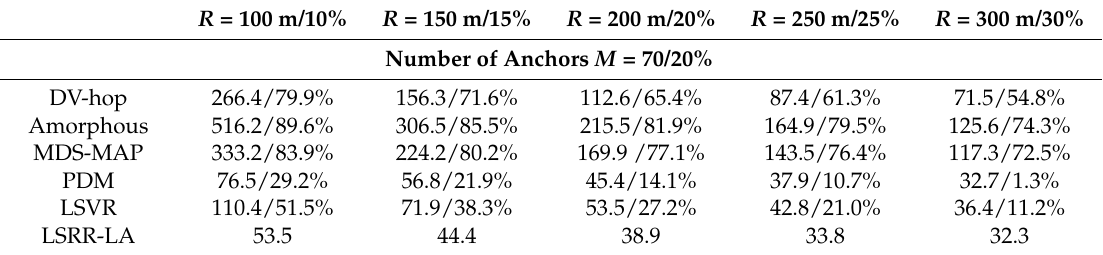
Table 5. Comparison of ALE under different radio ranges in the random deployment network.